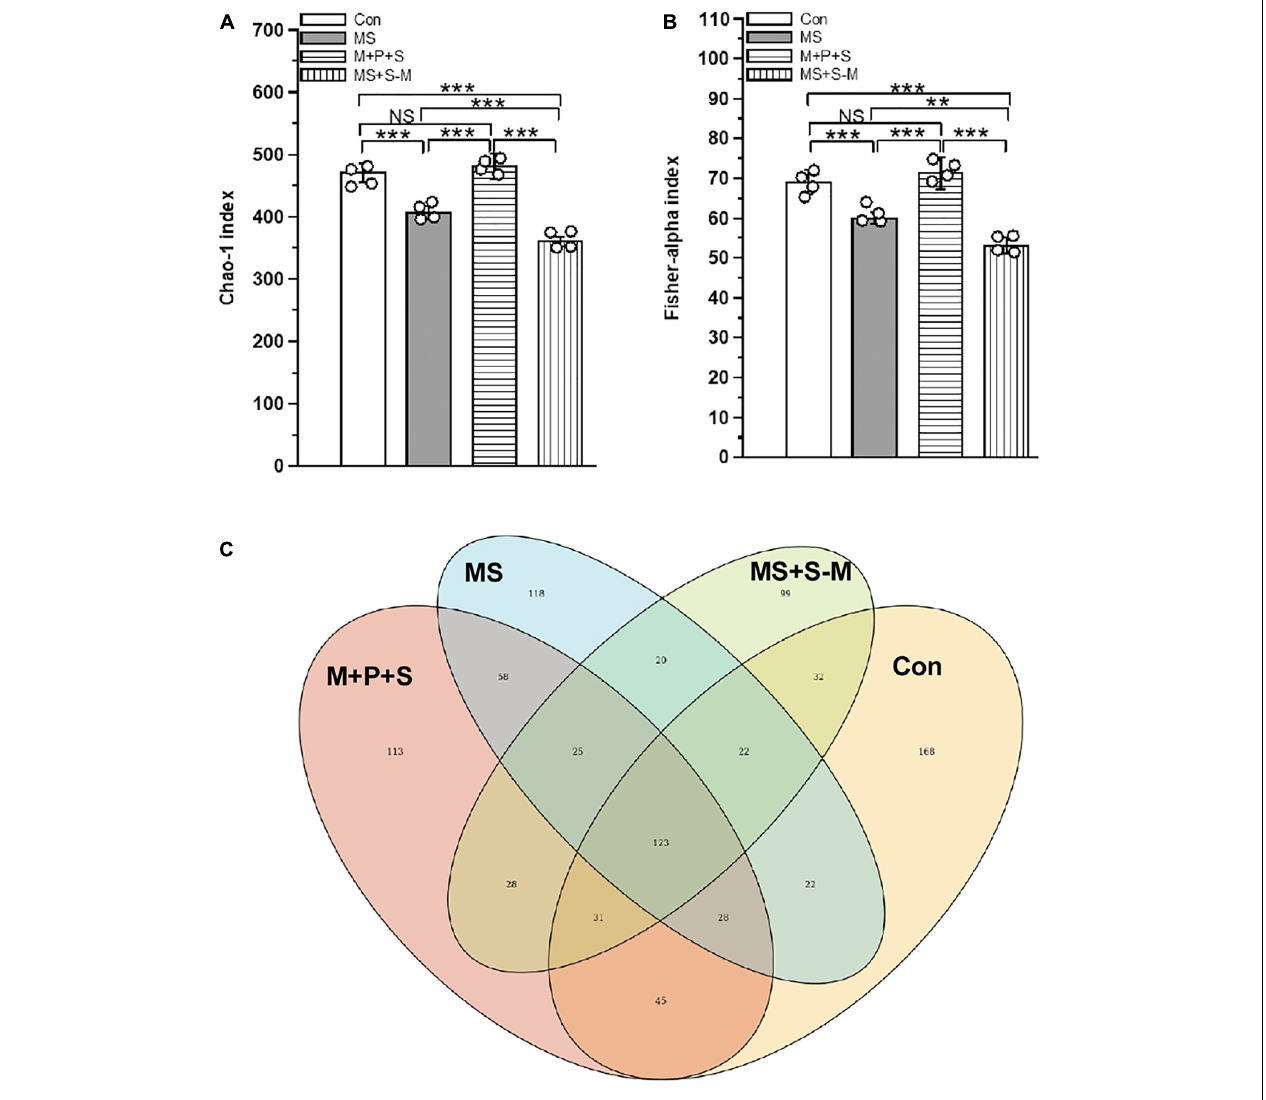
FIGURE 1 | Alpha-diversity of the fecal microbiota in rat pups after experiencing early life social stress (A) Chao-1 index and (B) Fisher-alpha index. (C) Venn diagram showing the identified current major total bacterial OTUs at the genus level, and the overlapping area are listed with shared OTUs. Values are presented as mean ± SEM. Significant differences between groups are indicated by *** P < 0.001, ** P < 0.01, NS, not